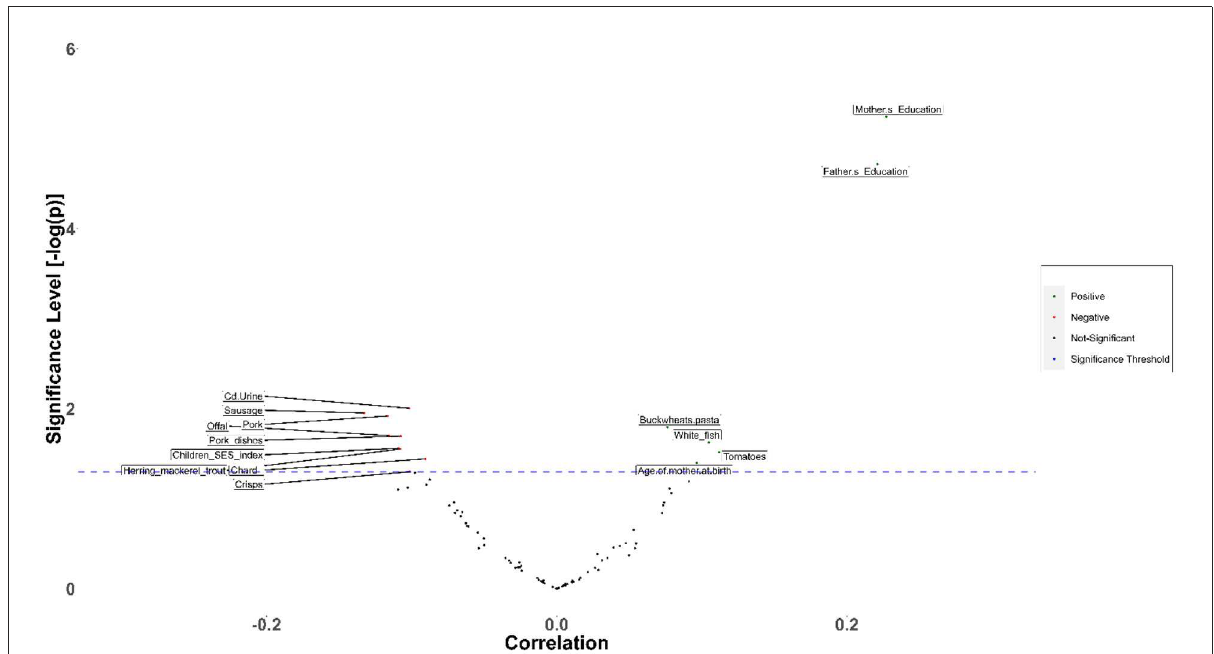
FIGURE14 Association of intelligence quotient with environmental, dietary and exposure factors in the framework of HERACLES cohort. Based on the analysis, distance of the living address has been pointed out as a key determinant for most of the WISC IV indices. With regard to the dietary factors, it was found that inclusion of tomatoes often in the diet, has a beneficial impact on IQ, Verbal Comprehension index and Working Memory. At the same time, cereal rich diets, are highly associated with the Perceptual Reasoning index. It has also to be noted that both tomatoes and cereals are beneficial for cognition indices. White fish has been found to be associated with lower score in Social Responsiveness Scale thus, to provide protection against ASD impairments, in contrast to other food items such as pork, sausages, crisps, herring mackerel, and chards that impact adversely social responsiveness. Besides nutrition, social factors, play an important and crucial